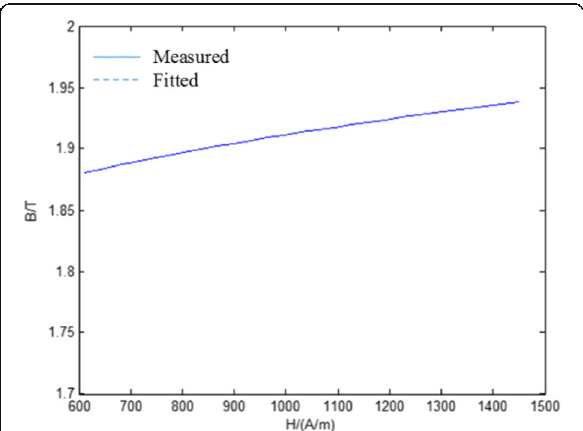
Fig. 5 Positive saturation curve of closed-core and its fitted curve